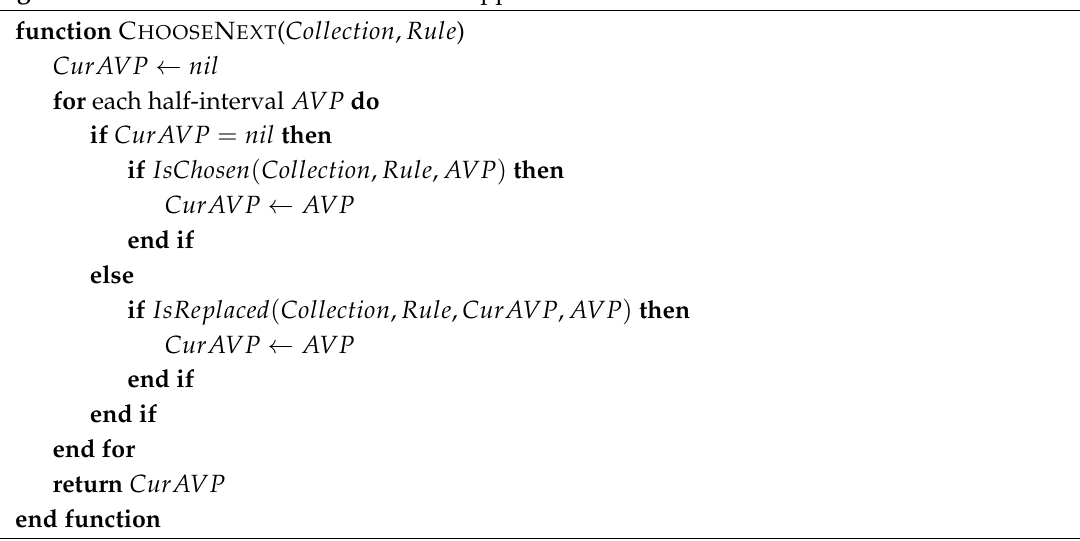
Algorithm 2 ChooseNext heuristic for RSC